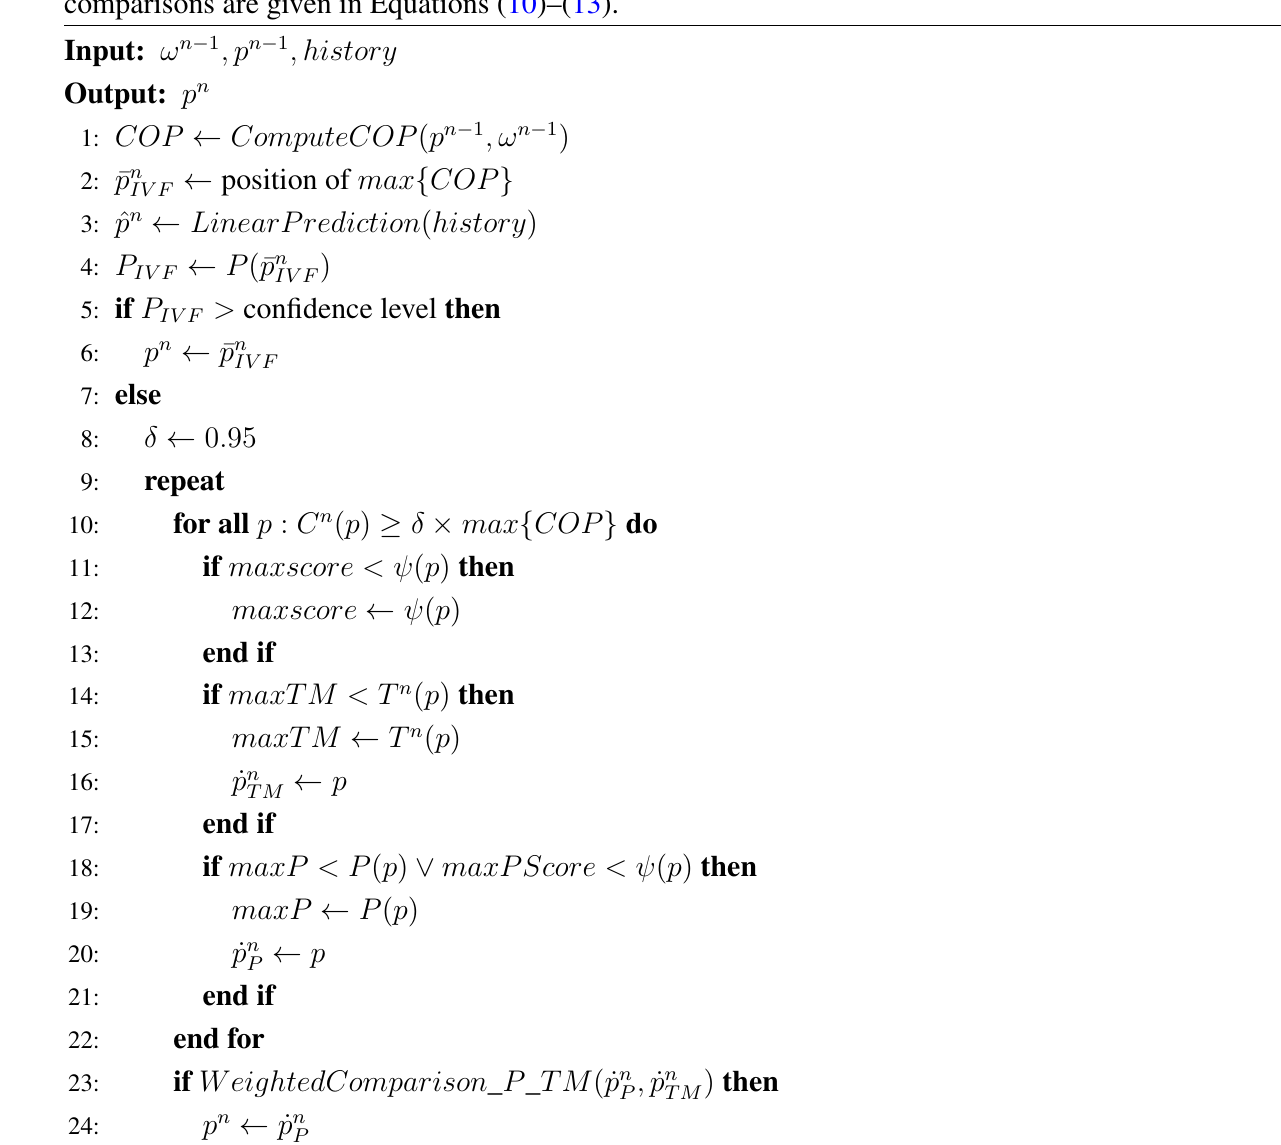
Algorithm 1 The proposed algorithm (see Table 1 for symbols meaning). Details on weighted comparisons are given in Equations